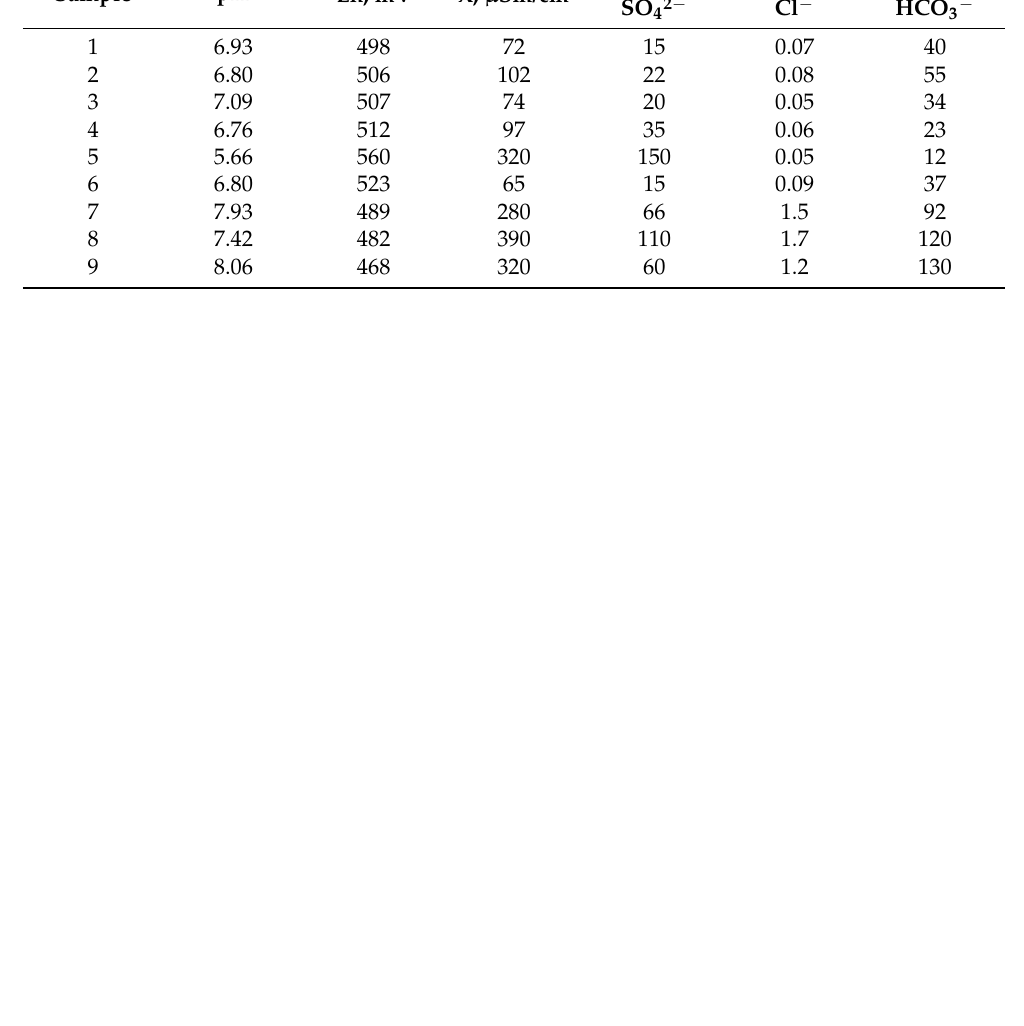
Table 2. Physicochemical composition of the water samples: a stream entering the surface of the tailings dump from the decay near the tailings (1); ponds on the surface of the tailings (2–5); natural stream flowing near the tailing dumps at a point lower in the relief (6); storage reservoir (7); Shahtama River (8); drinking water well (9).